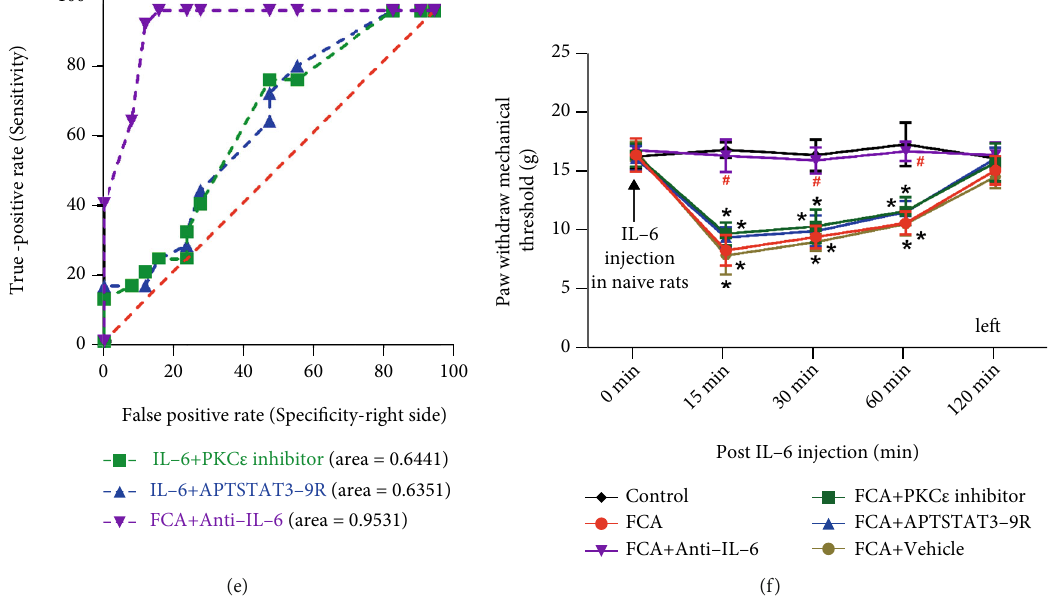
Figure 4: Evaluation of paw withdrawal mechanical threshold (PWMT) in rats with in fl ammatory pain and IL-6-induced hyperalgesia after the administration of PKC ε inhibitor peptide, APTSTAT3-9R (STAT3 inhibitor), or anti-IL-6 antibody. (a) Anti-IL-6 antibody (100ng/ 50 μ L) rapidly attenuated FCA-induced pain for several days on the ipsilateral in fl amed side. PKC ε inhibitor peptide (100 μ g/50 μ L) and APTSTAT3-9R (20 μ g/50 μ L) exerted antinociceptive e ff ects 24h after drug injection. ∗ P < 0 : 05 versus control. # P < 0 : 05 versus FCA, one-way ANOVA followed by Bonferroni tests. (b) ROC curves and AUC of PKC ε inhibitor peptide, APTSTAT3-9R, and anti-IL-6 on the ipsilateral side of FCA-treated rats. (c) None of the PKC ε inhibitor peptide, APTSTAT3-9R, and anti-IL-6 a ff ected contralateral mechanical paw withdrawal thresholds in rats with FCA-induced in fl ammatory pain. (d, f) Interleukin-6 (20 ng/50 μ L) microinjected 10min after naïve rats were injected with PKC ε inhibitor peptide (100 μ g/50 μ L) or APTSTAT3-9R (20 μ g/50 μ L) did not a ff ect IL-6- induced mechanical hyperalgesia, whereas anti-IL-6 antibody (100ng/50 μ L) did. ∗ P < 0 : 05 versus control. # P < 0 : 05 versus IL-6, one-way ANOVA followed by Bonferroni tests. (e) ROC curves and AUC of PKC ε inhibitor peptide, APTSTAT3-9R, and anti-IL-6 in the right hind paws of naïve rats. Data are shown as means ± SD ( n = 6 ). AUC: area under receiver operating characteristic curve; ROC: receiver operator characteristics